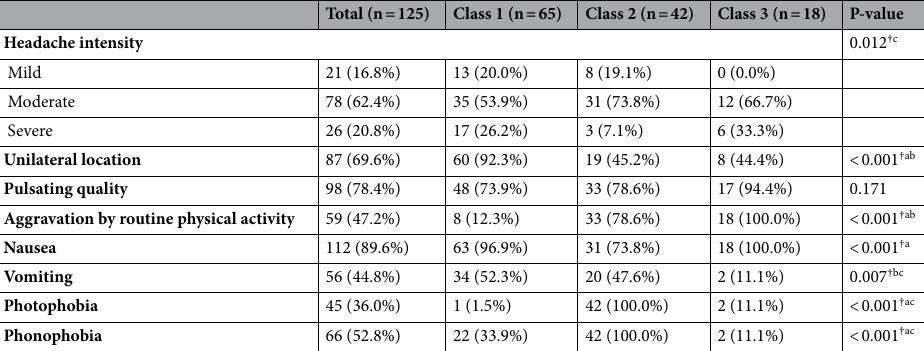
Table 3. Characteristics of headache under the diagnostic criteria of migraine in the third edition of the International Classification of Headache Disorders. Data are presented as n (%). † Significant P-value. a Significant difference between Class 1 and Class 2 in multiple comparisons. b Significant difference between Class 1 and Class 3 in multiple comparisons. c Significant difference between Class 2 and Class 3 in multiple